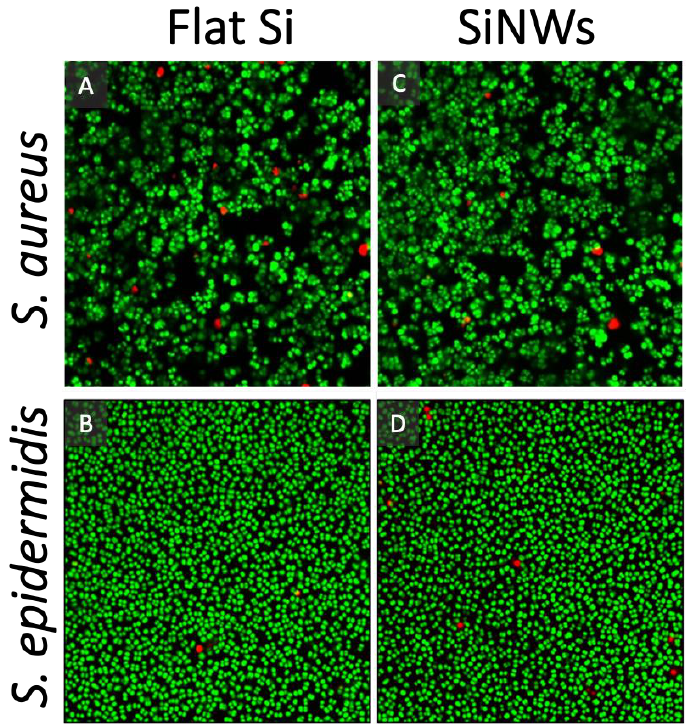
Figure 4. Representative Live/Dead Confocal Scanning Laser Microscopy (CSLM) images for Staphylococcus spp. stained with Syto9 (green, live) and propidium iodide (red, dead) cultured for 24 h over: ( A , B ) Flat silicon; and ( C , D ) SiNW surfaces. Field of view is 71.8 µm × 71.8 µm. The confocal images were taken at the interface between the surfaces and the biofilm, showing only the first layer of cells in contact with the surface.